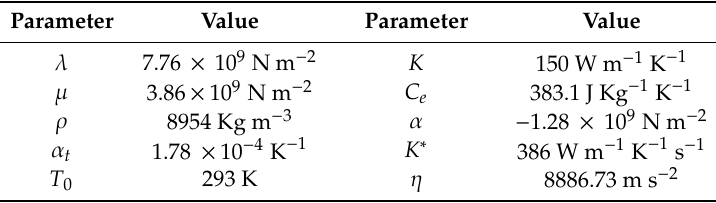
Table 1. Physical constants for chosen material